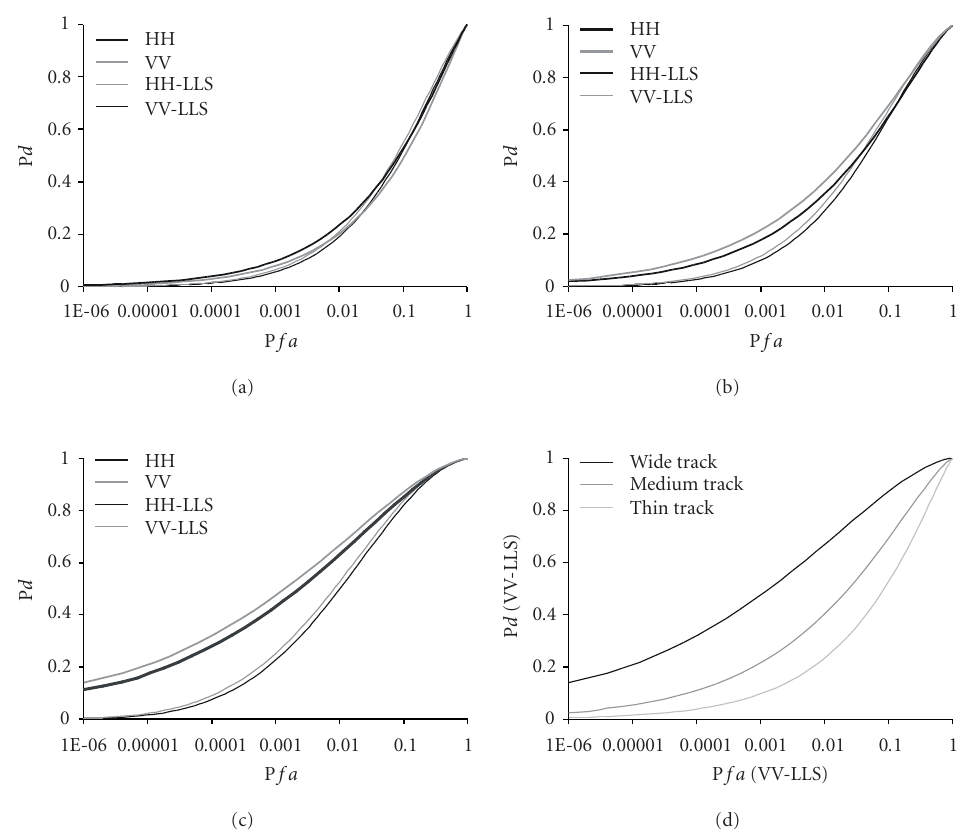
Figure 6: ROC curves determined using the coherency distributions recovered for the simulated copolar channels. (a) Thin track and (b) medium track. (c) Wide track and (d) all tracks in the VV, log-likelihood